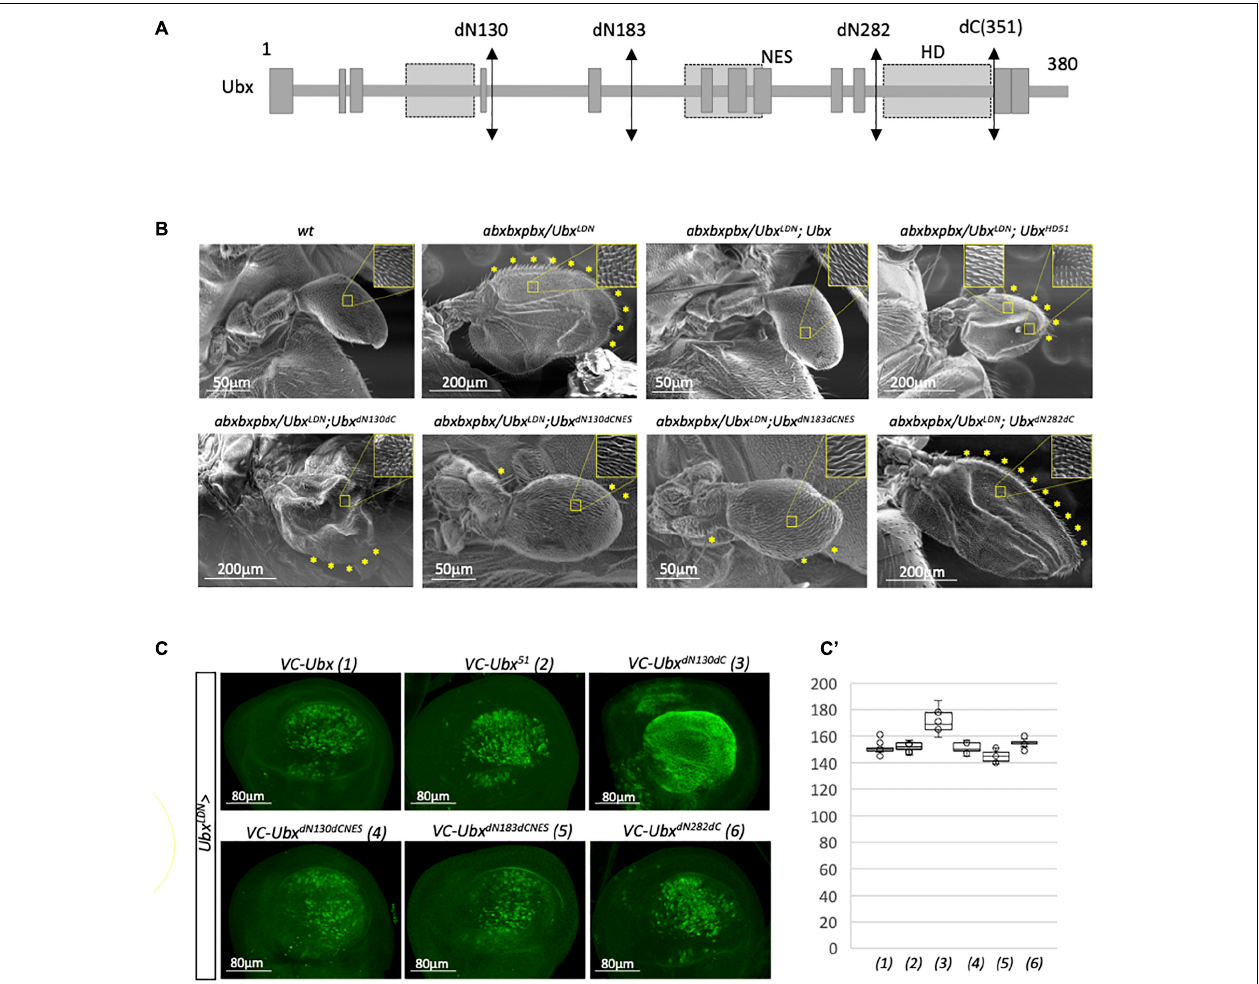
FIGURE 3 | A minimal form of Ubx can rescue the haltere-to-wing mutant phenotype. (A) Schematic representation of Ubx with the different sites of deletion. The emplacement of the homeodomain (HD), residue 51 of the HD and unconventional Nuclear Export Signal (NES) are indicated. The NES overlaps with the conserved hexapeptide (HX) motif of Ubx (Duffraisse et al., 2020). (B) Illustrative SEM pictures of the activity of the different deleted and mutated forms of Ubx in the rescue assay. The haltere-to-wing mutant context results from the combination of the abxbxpbx allele over the hypomorphic Ubx LDN that corresponds to the insertion of